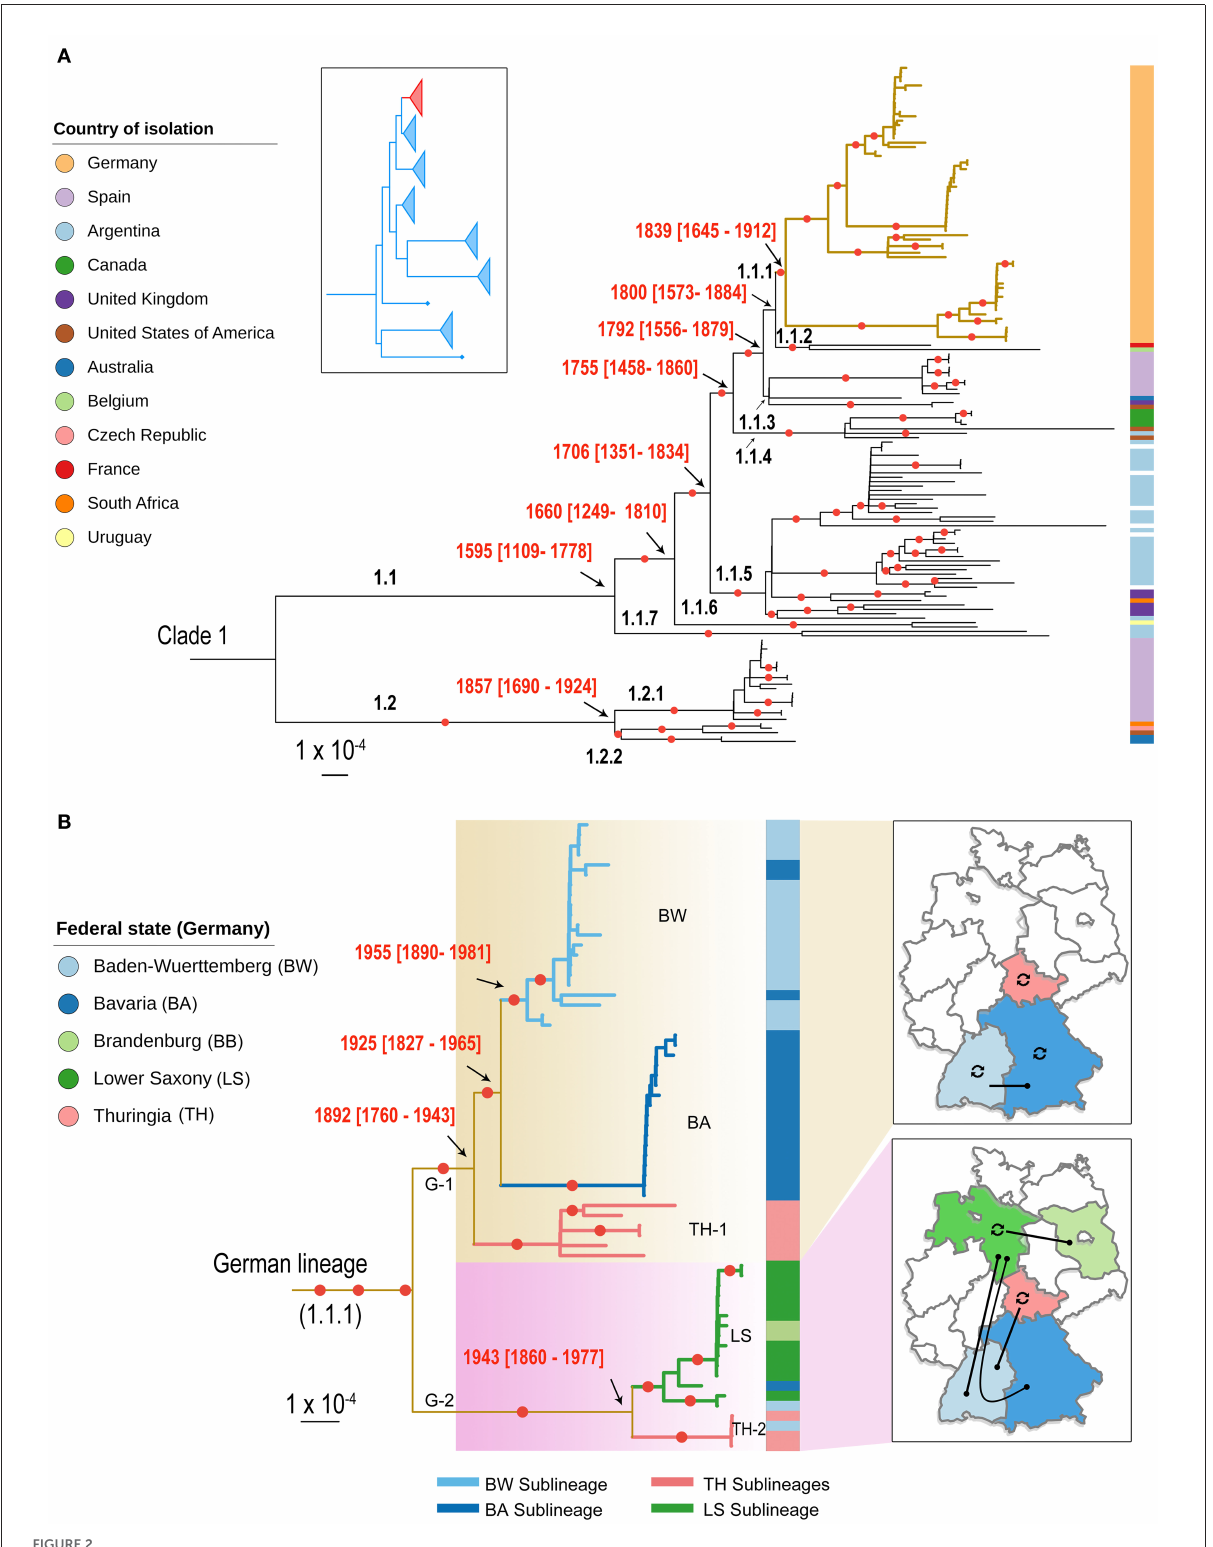
FIGURE2 Population structure of C. fetus subsp. venerealis ( Cfv ) strains. (A) A contextual phylogenetic analysis of the 63 German Cfv strains (1985–2015) in the light of global data from 11 countries is extrapolated by a midpoint-rooted maximum likelihood (ML) phylogenetic tree of clade 1.